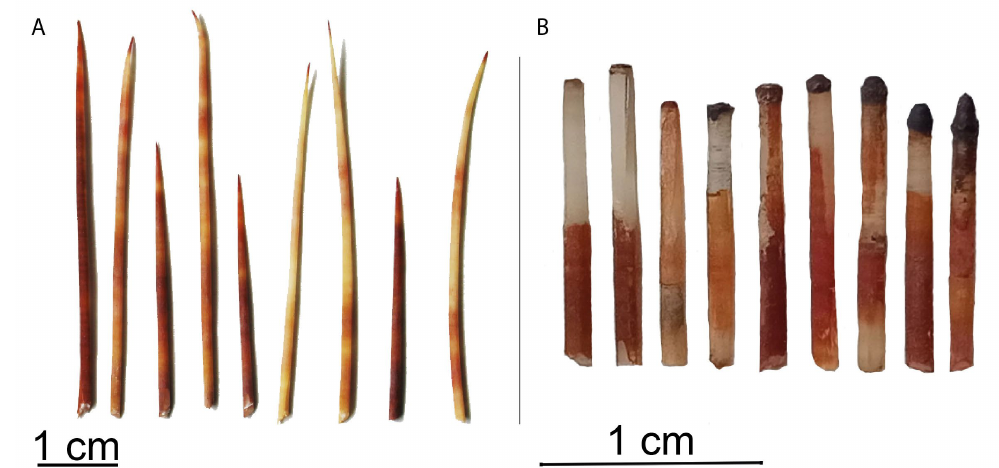
Figure 18: Sample of Melocactus intortus thorn drills before and after use. We can observe the change of the shape of the active part according to the wear of the drill, which very often burned because of the friction.